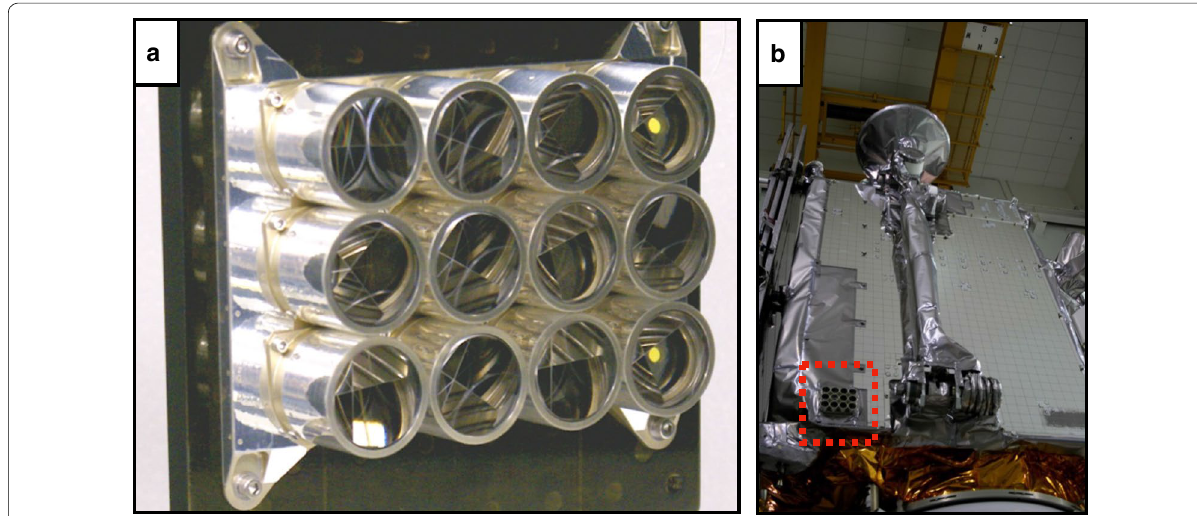
Fig. 1 Photographs of the LRA mounted on the LRO spacecraft. a Close‑up view. b Context view of the anti‑nadir deck. The large arm holding the HGA is visible in its stowed configuration